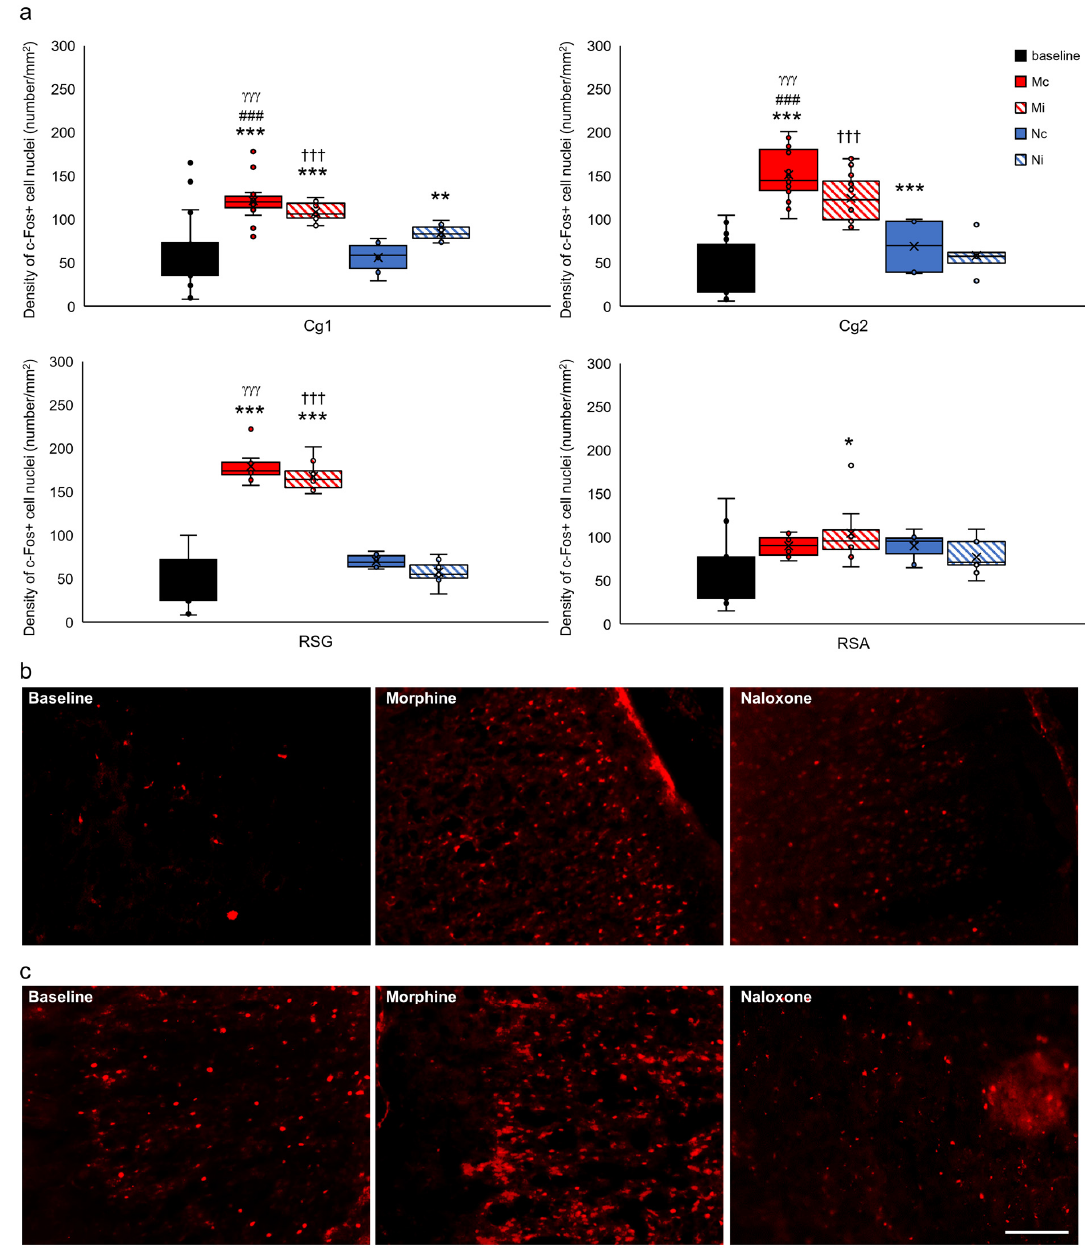
Figure 7. Density of c-Fos+ cell nuclei (number/1 mm 2 ) in select limbic structures of the cortex in the brains of rats that were subjected to VTA electrical stimulation (Es-VTA) only (baseline group, n = 5) (black-filled bars) and in the brains of rats administered Es-VTA and a one-time injection of morphine (1.5 µ g) or naloxone (25.0 µ g) injected into the PPN in the contralateral (Mc, n = 5, red-filled bars; Nc, n = 6, blue-filled bars) and ipsilateral hemispheres (Mi, n = 5, red-hatched bars; Ni, n = 6, blue-hatched bars) ( a ). Representative photomicrographs of c-Fos-labeled neurons in the Cg1 ( b ) and Cg2 ( c ) structures are shown. Scale bar = 100 µ m (white line: right lower corner of the last photo, panel ( c )). Tukey’s post hoc test: * p < 0.05, ** p < 0.01, and *** p < 0.001 indicate a significant difference between the baseline and other experimental groups (Mc, Mi, Nc, and Ni groups); ### p < 0.001 indicate a significant difference in the morphine groups between different injection site: contra- or ipsilateral hemispheres (Mc vs. Mi group); γγγ p < 0.001 indicate a significant difference in the contralateral side groups between different injection drug: morphine or naloxone (Mc vs. Nc group); ††† p < 0.001 indicate a significant difference in the ipsilateral side groups between different injection drug: morphine or naloxone (Mi vs. Ni